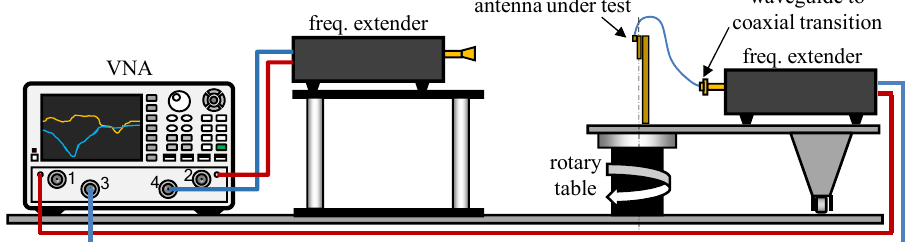
Figure 14. Radiation pattern measurement setup.